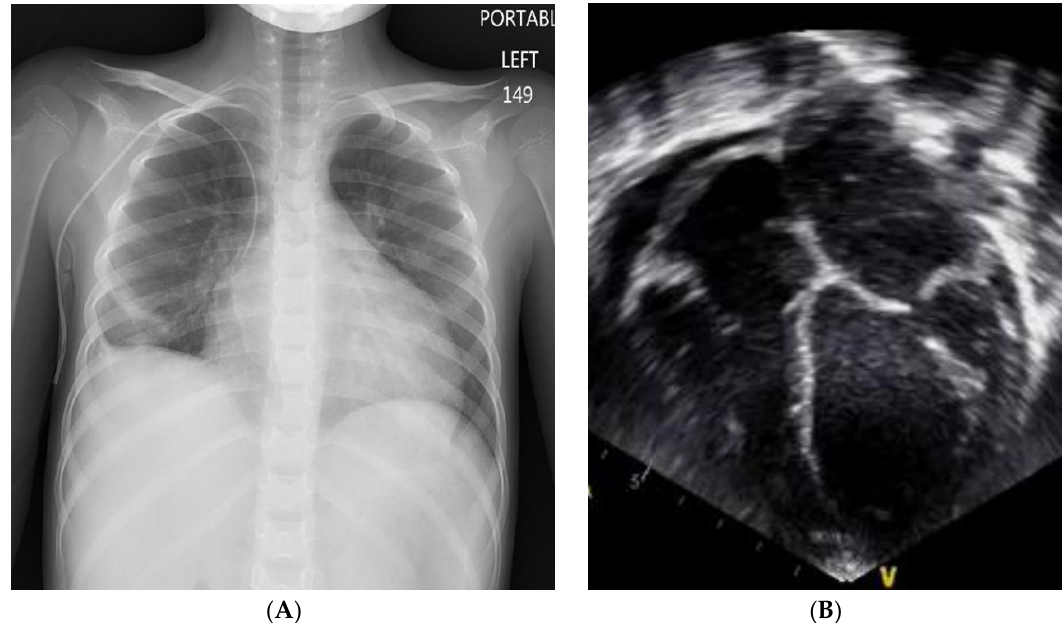
Figure 1. Myocardial recovery after VAD implant. ( A ) Chest x-ray image prior to VAD implant showing cardiomegaly. ( B ) Prior to VAD implant, trans-thoracic echocardiogram in the apical four-chamber view showing a moderately dilated left atrium (LA) and left ventricle (LV) with ventricular wall thinning and moderately depressed systolic function with a shortening fraction of 16% and calculated LVEF of 38%.